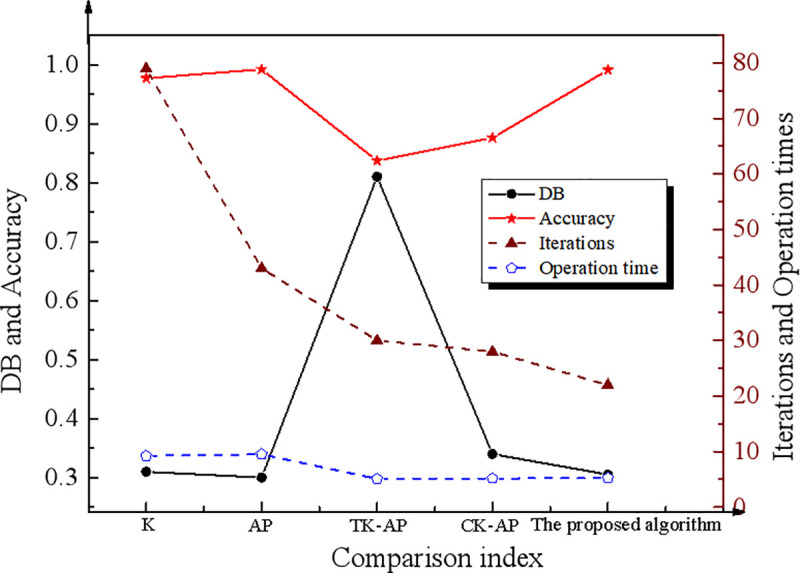
Comparison of several algorithms’ performances.